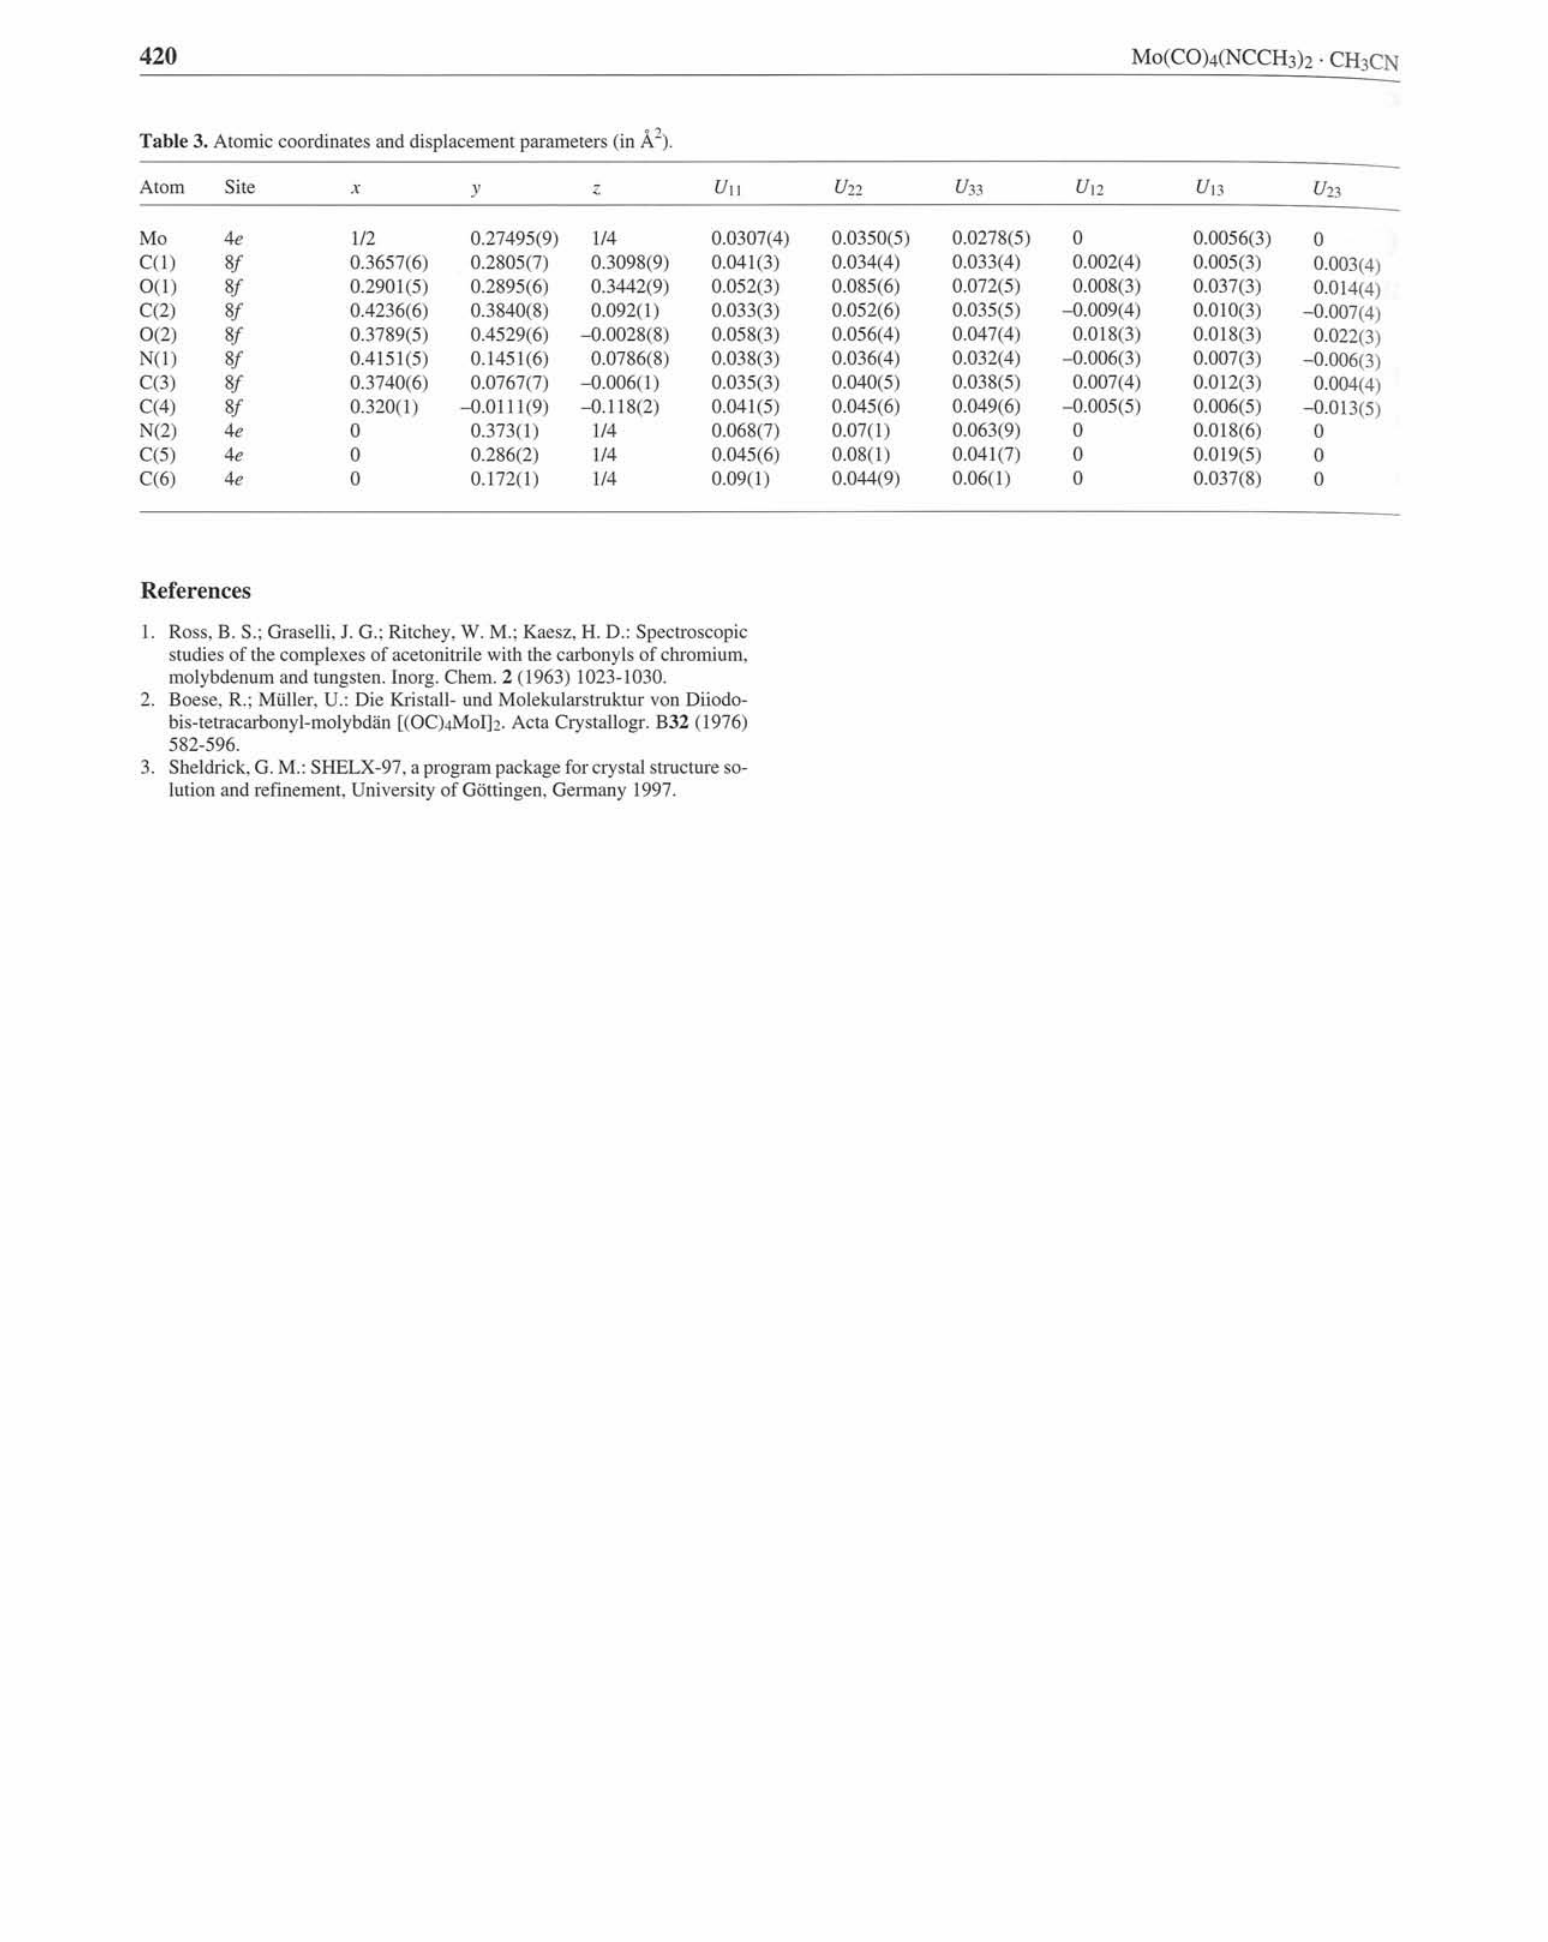
Table 3. Atomic coordinates and displacement parameters (in Â 2